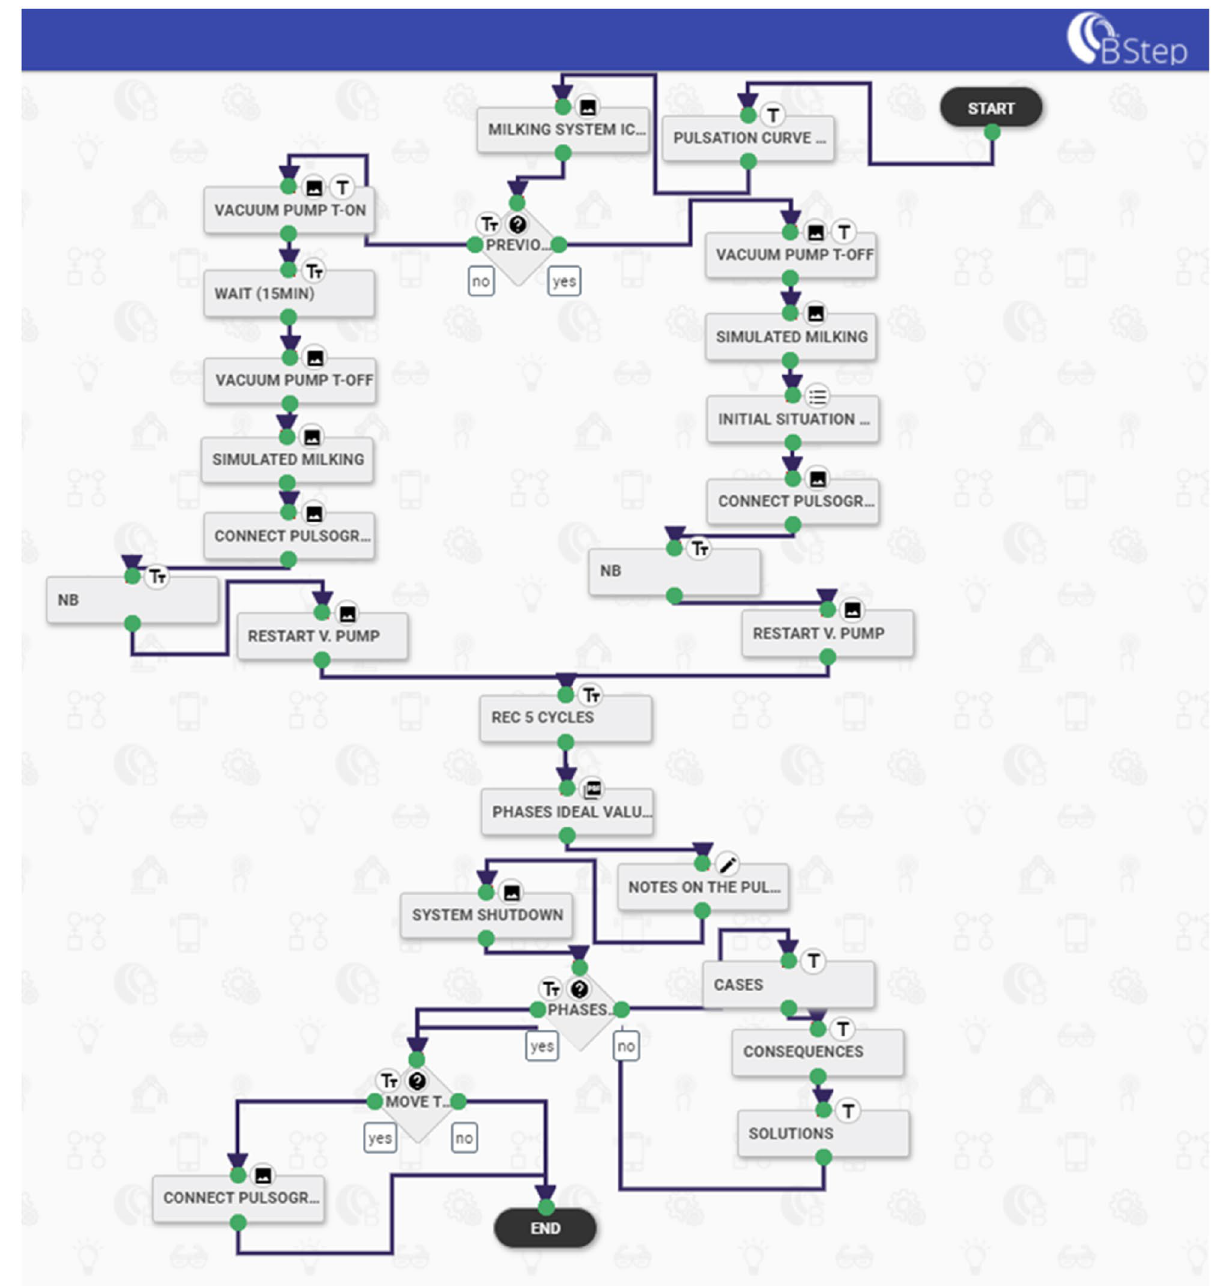
Figure 4. Mechanical milking installations tests: workflow scheme built with the BStep application software describing the steps of the pulsation characteristics